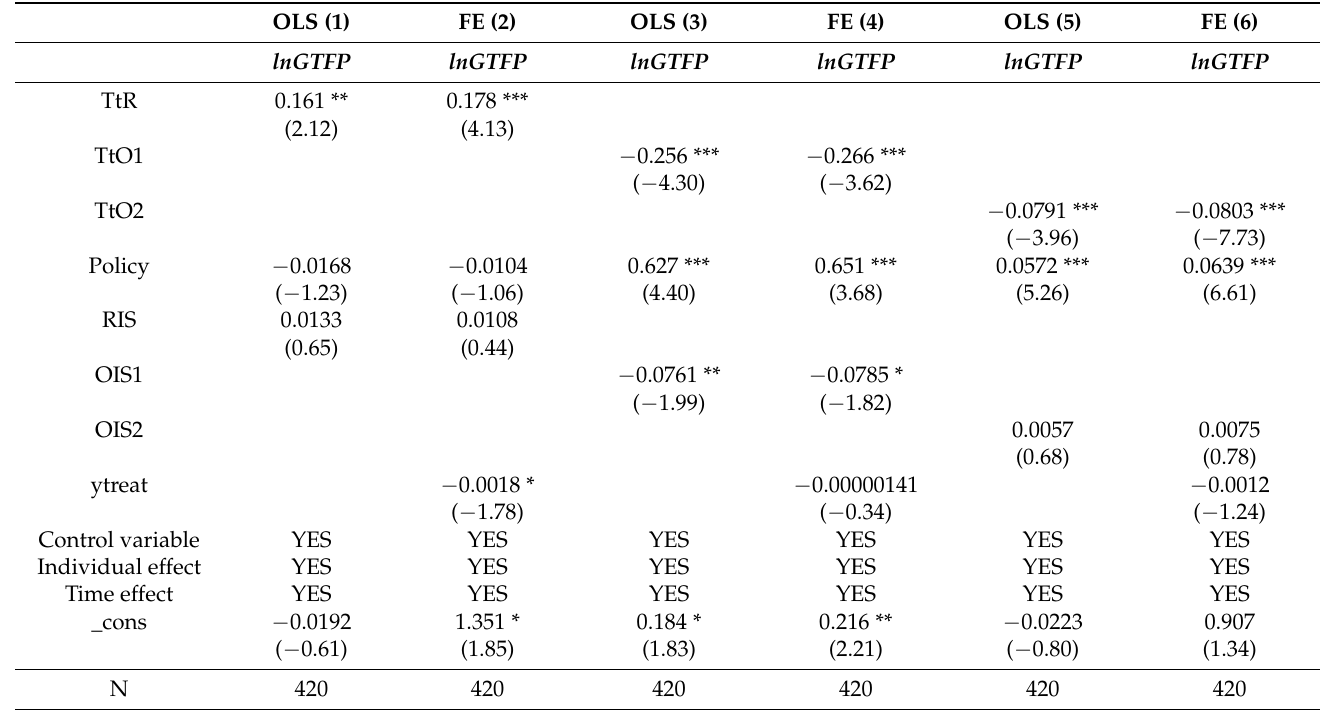
Table 8. Test of the moderating effect of industrial structure on